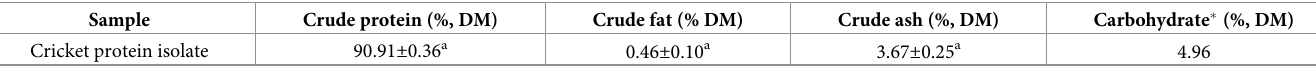
Table 2. Composition (g/100g) of Gryllus bimaculatus protein isolate (mean ± S.D., n = 3).